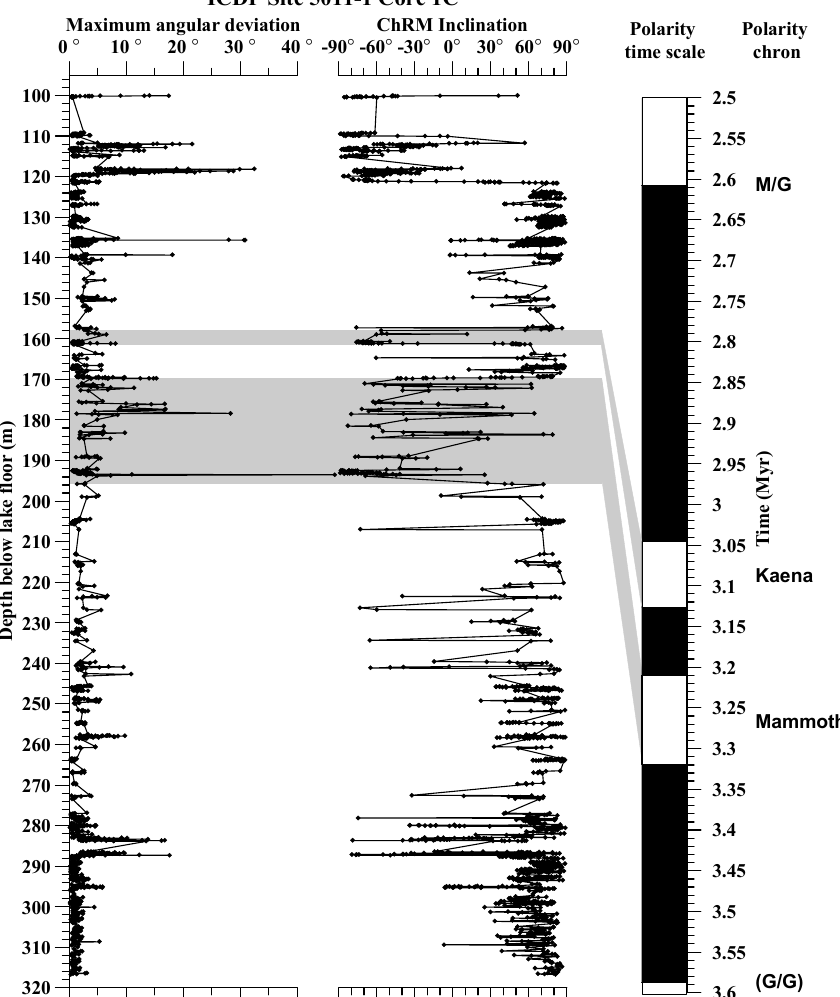
Fig. 7. Down-core variations in the inclinations of the characteristic remanent magnetization (ChRM) and maximum angular deviation (MAD) from core 1C. Shaded areas denote correlation of the ChRM inclination with the polarity timescale. Gauss/Gilbert (G/G) boundary at 3.588Ma is not recorded by the